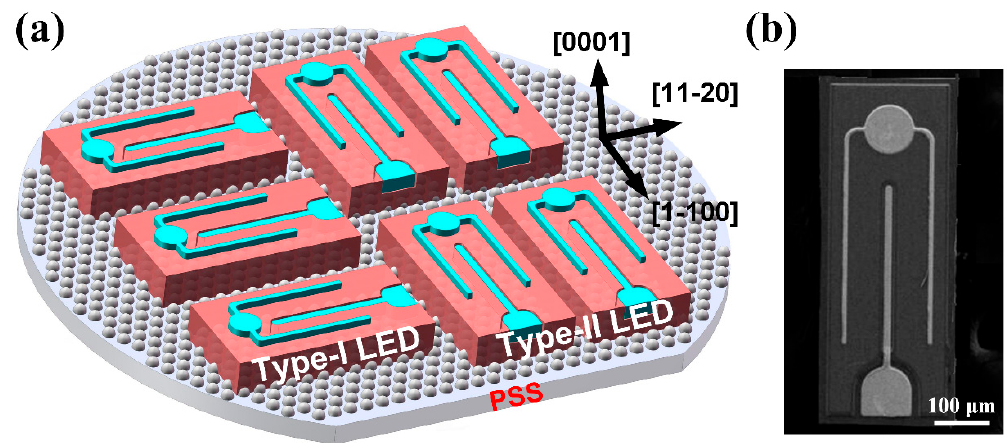
Figure 1. ( a ) Schematic diagram of Type-I LED and Type-II LED with different sidewall orientations. ( b ) SEM image of the fabricated LED chip.